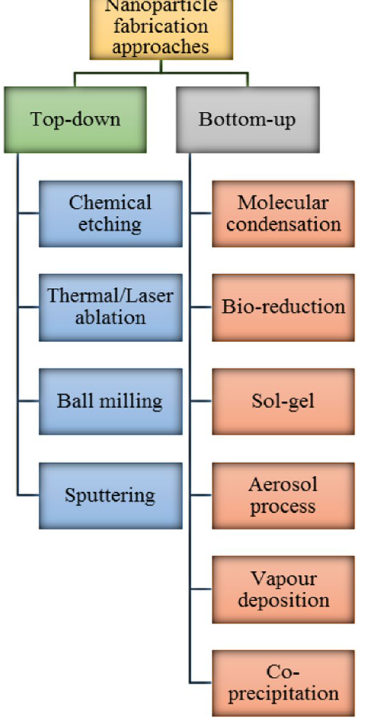
Fig. 3 Various methods used for the fabrication of nanoparticles (Ira- vani